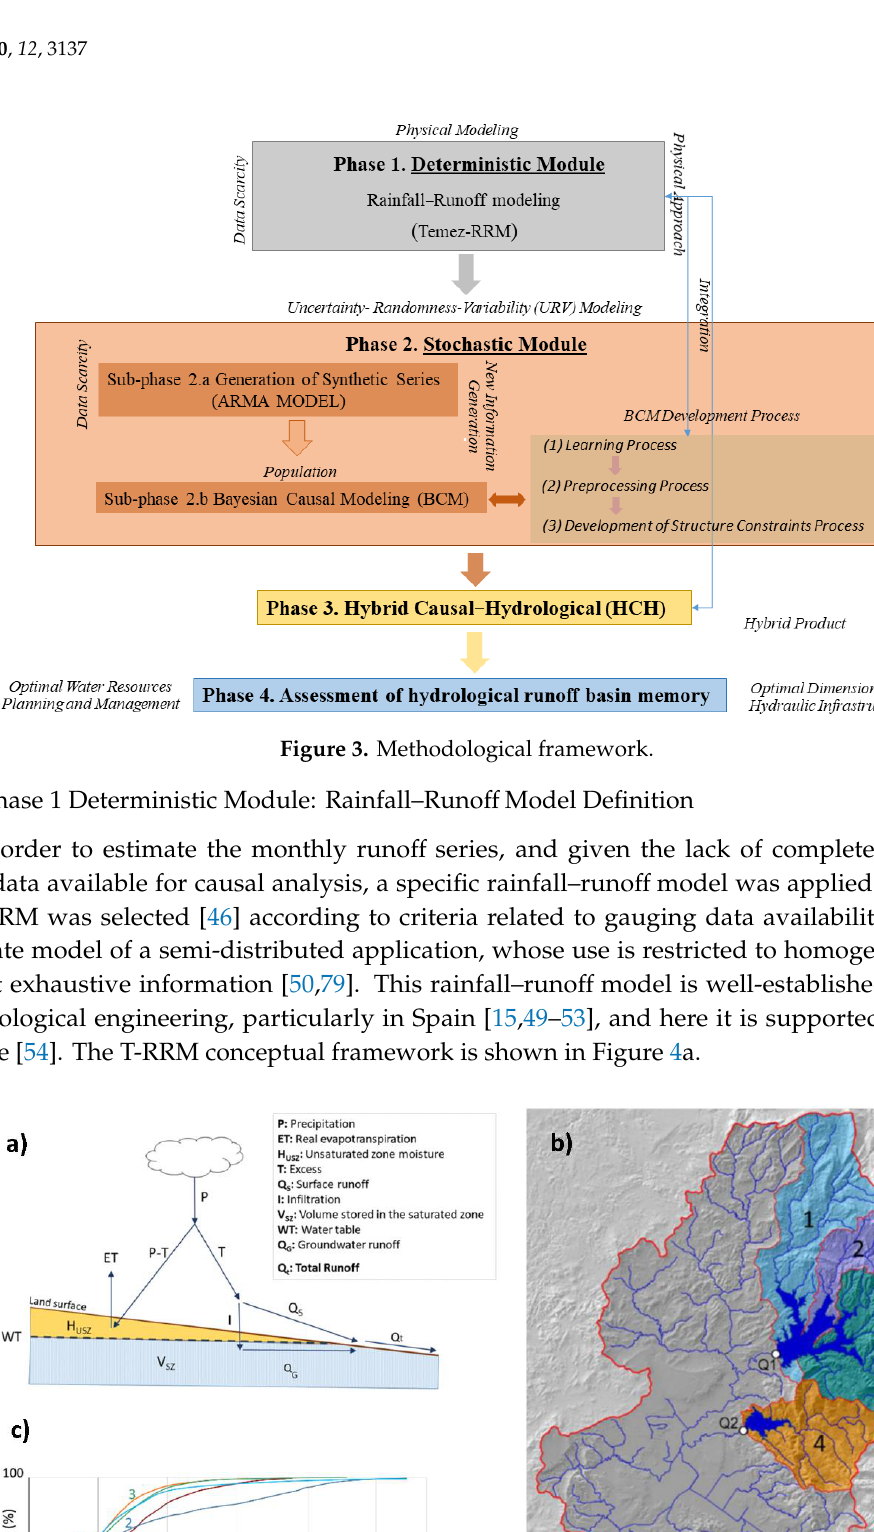
Table 1. Main morphometric characteristics of the studied sub-basins.